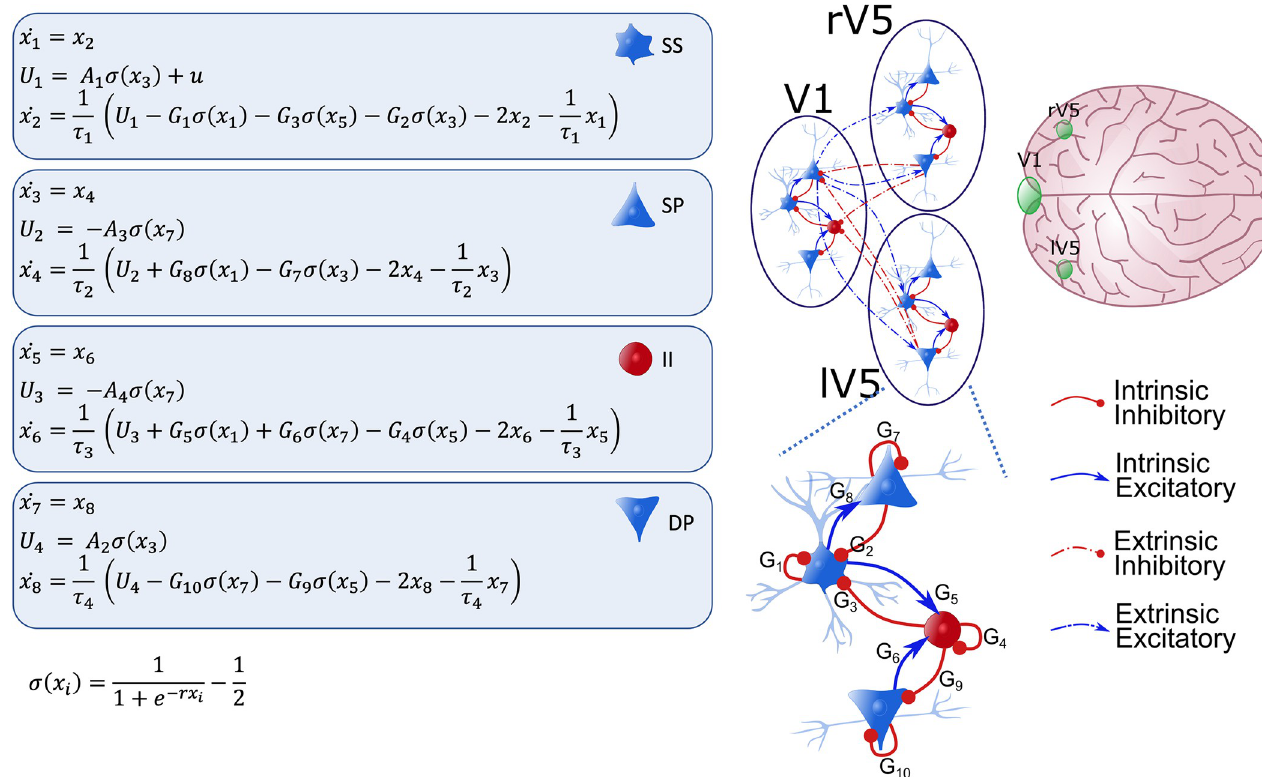
Fig 1. Illustration of the Canonical Microcircuit Model (CMC) model. Each source (V1, rV5 and lV5) comprises 4 neural subpopulations: spiny stellate cells (SS), superficial pyramidal cells (SP), deep pyramidal cells (DP) and inhibitory interneurons (II). Neural populations within a source are coupled with intrinsic connections (full arrows; bottom figure), while coupling between neural populations of different sources are extrinsic connections (dotted arrows). Red and blue arrows denote inhibitory and excitatory connections, respectively. The dynamics of the hidden (neuronal) states of each population can be described with the pairs of differential equations shown. There are four extrinsic connections: from SP to SS and DP (forward). Also, from DP to SP and II (backward). Intrinsic couplings are parametrized by G 1,..,10 . Three regions comprise the network that is assumed to generate observed cross-spectral densities: V1 and left and right V5. These are shown on the top right. Forward connections were specified from V1 to V5 while backward connections were specified from V5 to V1. σ ( x i ) is a sigmoidal activation function which transforms post-synaptic potential into average spiking output, with r a parameter controlling the steepness. Finally, the external input to a brain source is denoted with u and enters SS. The free parameters shown in the figure are also listed in Table 1.